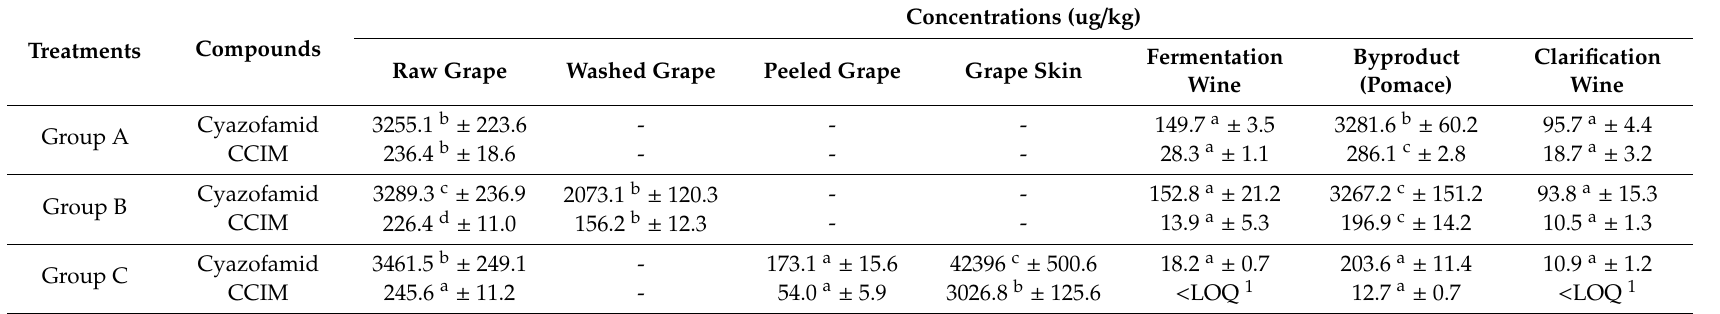
Table 2. The concentration of cyazofamid and CCIM of grape samples after di ff erent process. ( n =